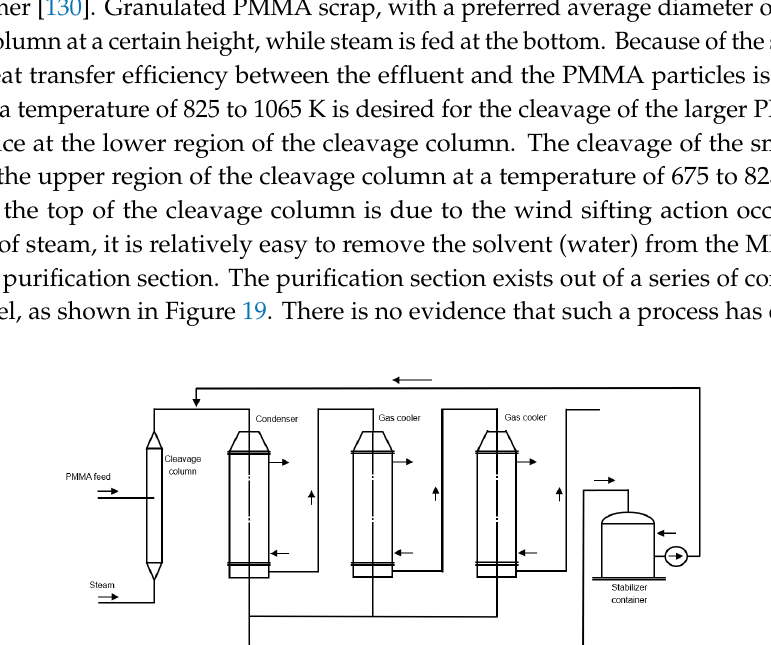
Figure 19. Configuration for the chemical recycling of PMMA as developed by Mannsfeld et al. based on counter current reactor technology [130] .